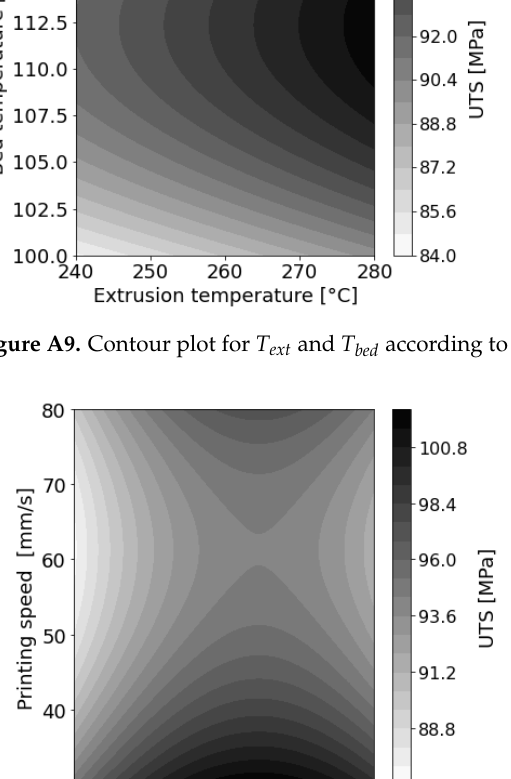
Figure A10. Contour plot for T bed and v according to the ML-based prediction model.